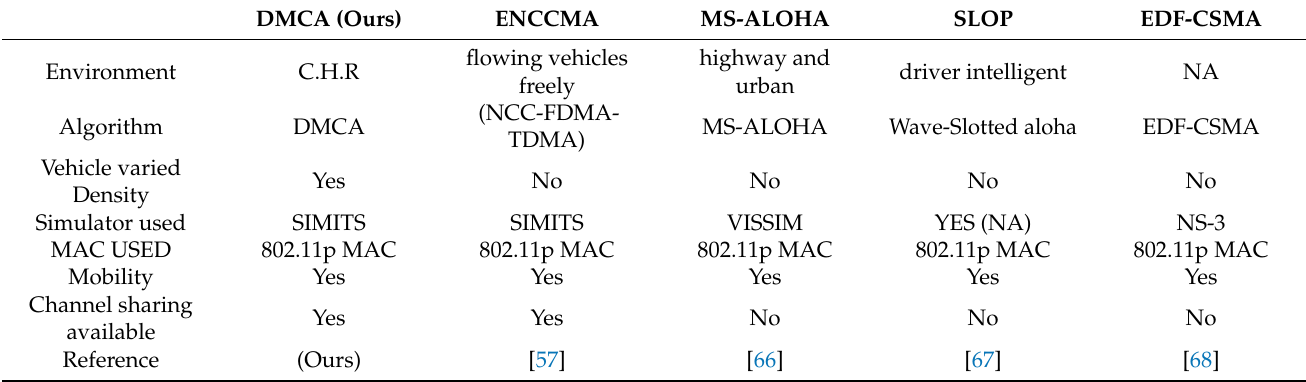
Table 4. State-of-the-art-techniques